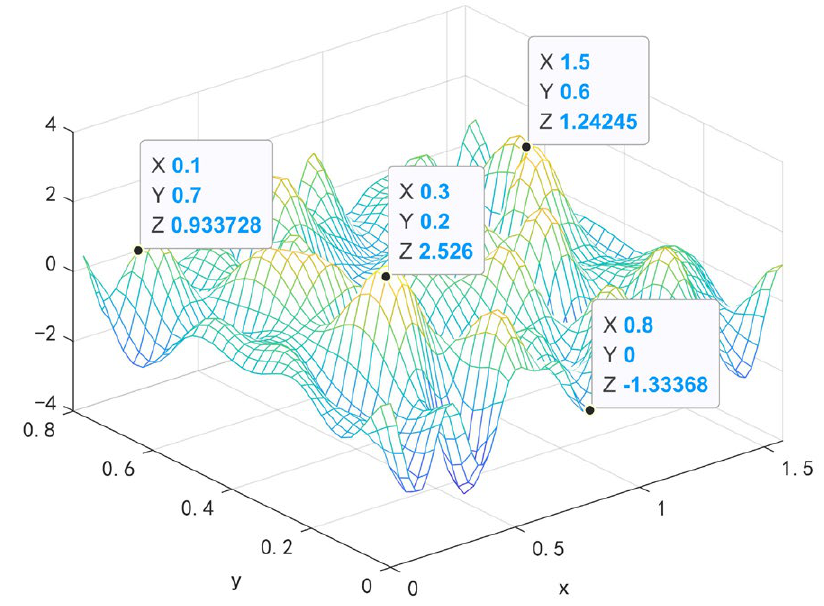
Figure 11. Generated two-dimensional discrete data after second zero-padding.